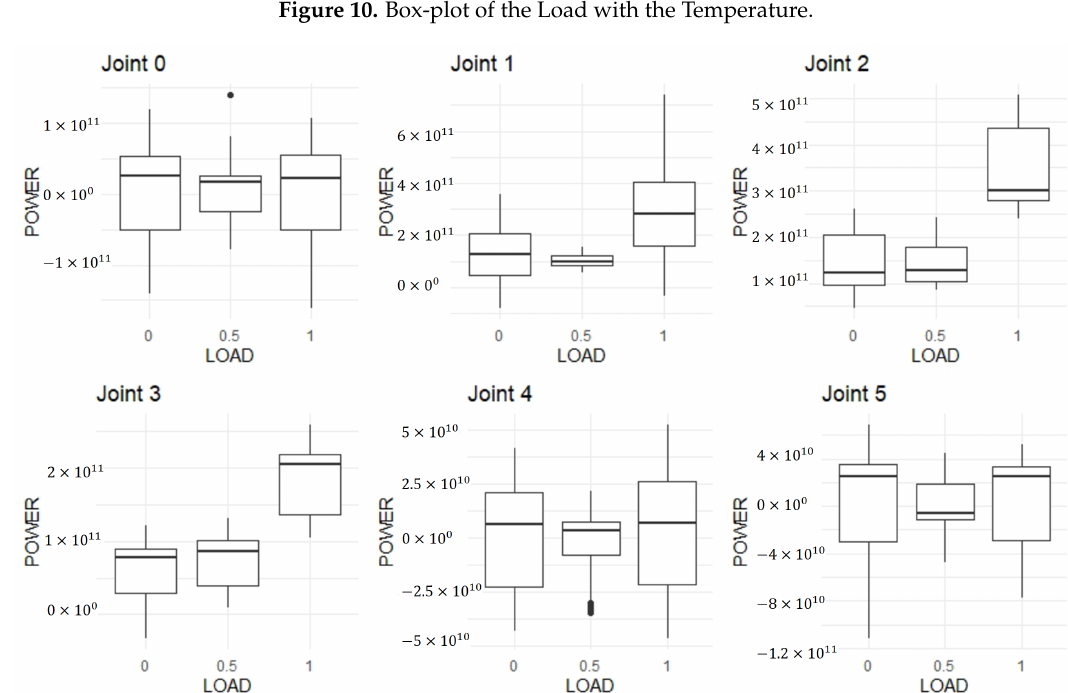
Figure 11. Box-plot of the Load and the